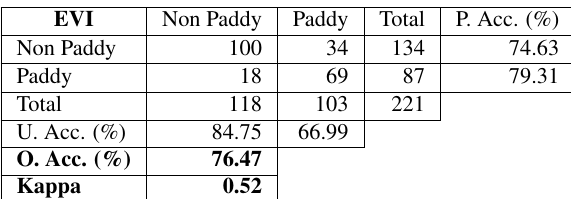
Figure 9: Rice Crop Intensity map from EVI in Sa Kaeo Province, Thailand)